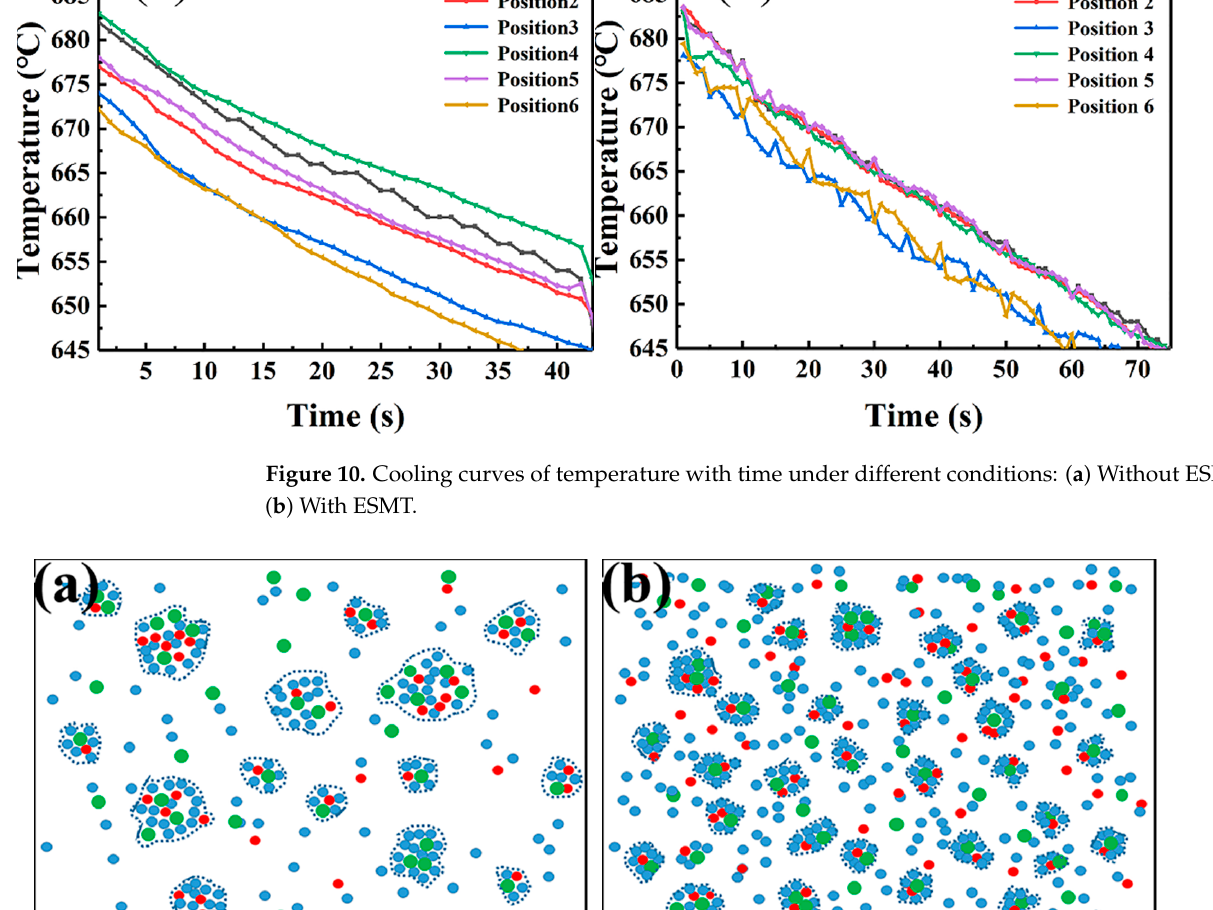
Crystals 2022 , 12 , x FOR PEER REVIEW